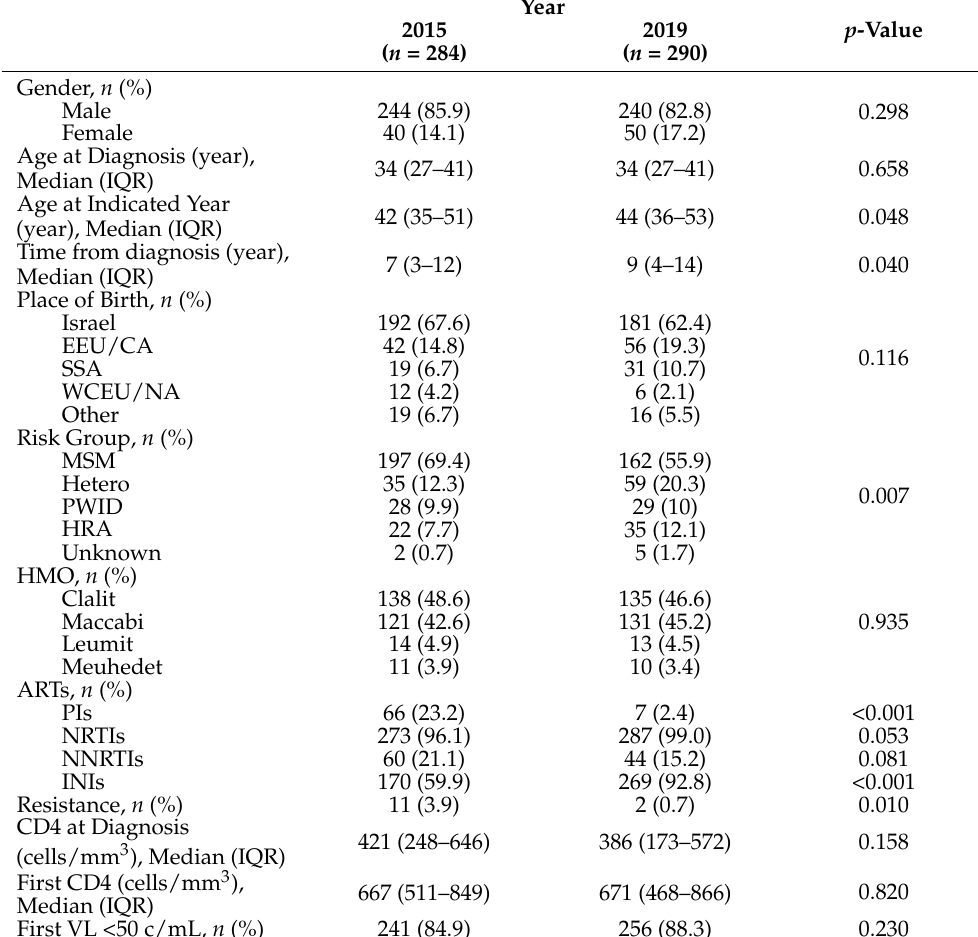
Table 1. Characterization of the patient population in 2015 and